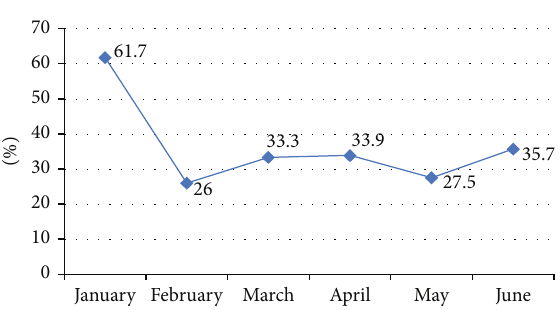
Figure1:Frequency(%)ofbloodstreaminfectionsamongadmitted neonates during the